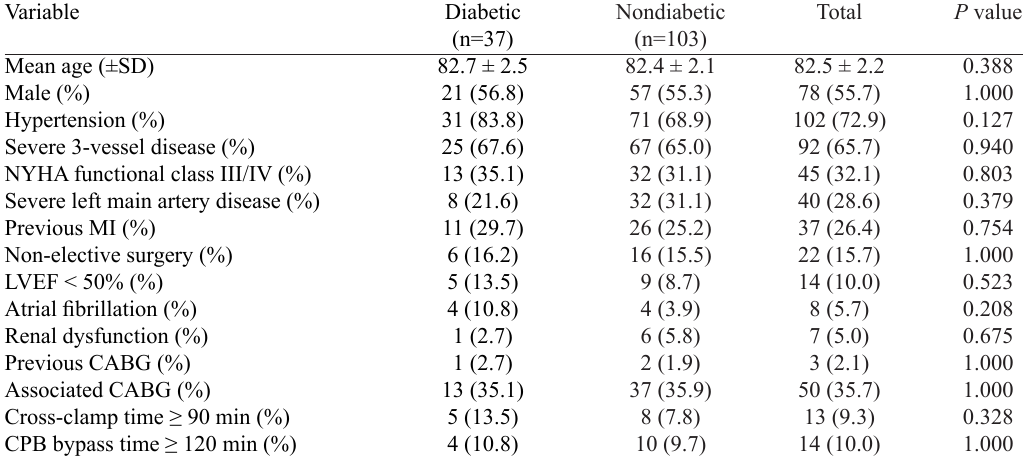
Table 1. Demographic baseline characteristics of diabetic and nondiabetic